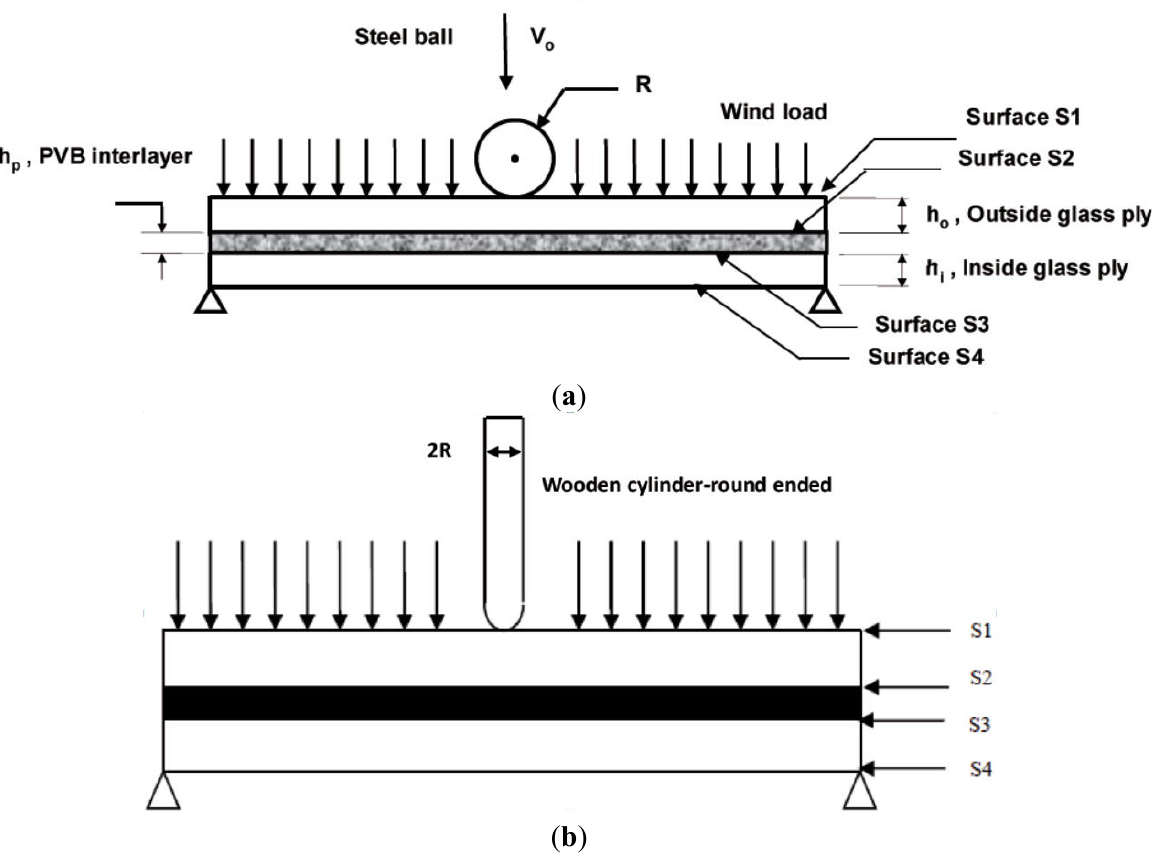
Figure 1. Schematic of different missile types impacting on 2-D laminated glazing. ( a ) Small missile; ( b ) Large missile with round impacting end; ( c ) Large missile with flat impacting